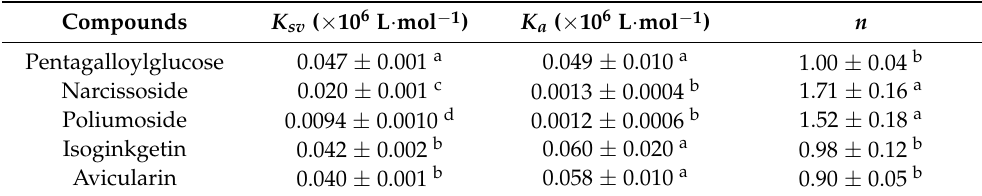
Table 2. Binding parameters of selected SPI–phytochemical compound